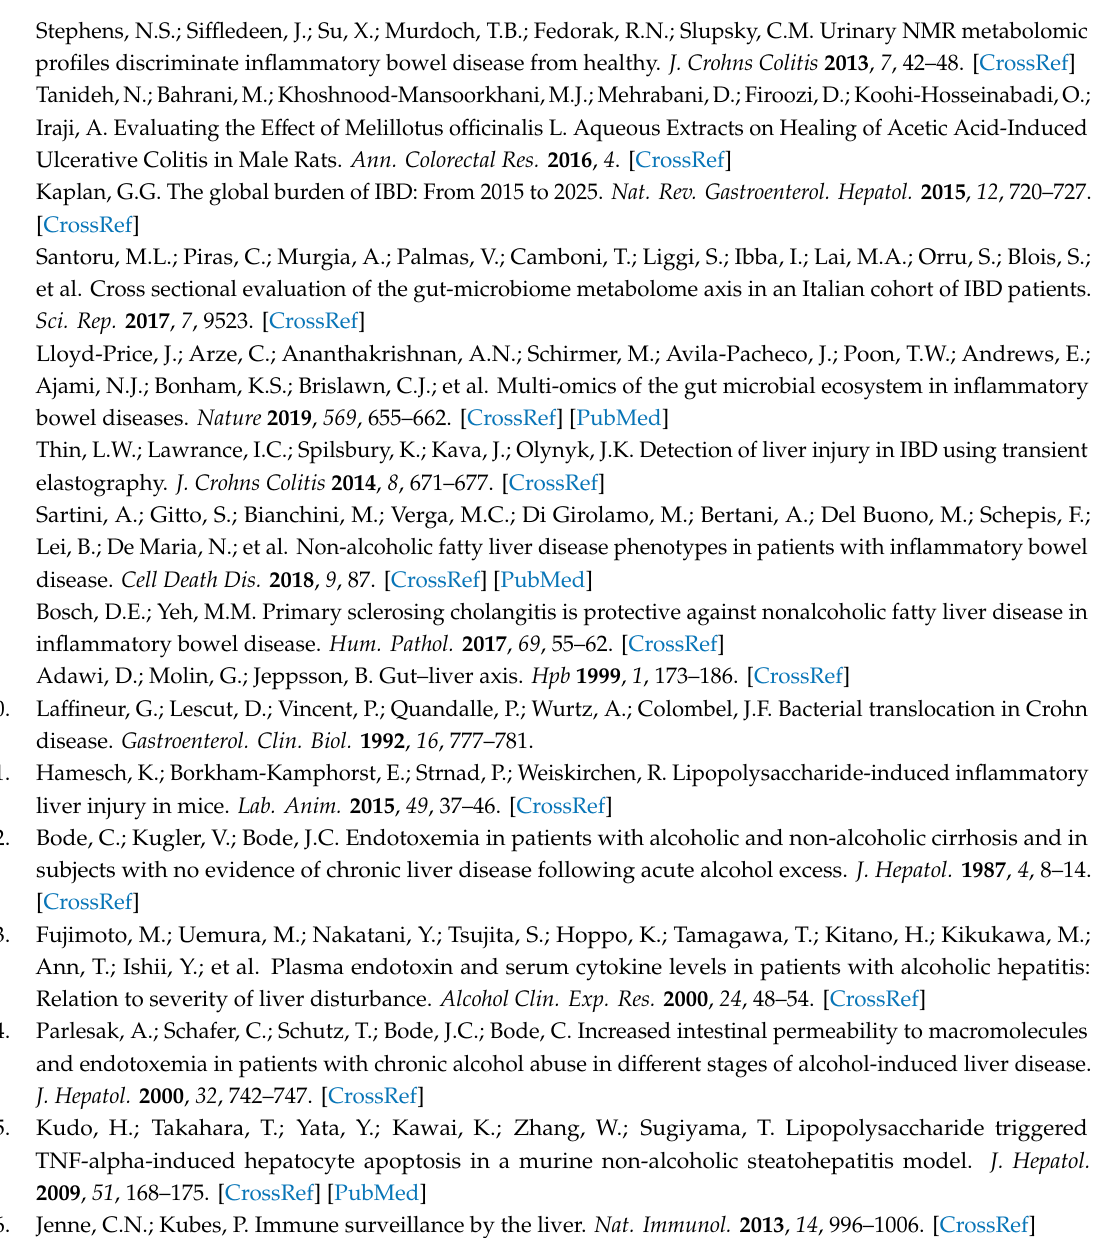
Figure S1: (A) Food intake and (B) water intake in DSS-treated mice. Mice were given 2%, 3.5%, and 5% DSS in drinking water for 7 days. Each value is represented as the mean ± SD of six